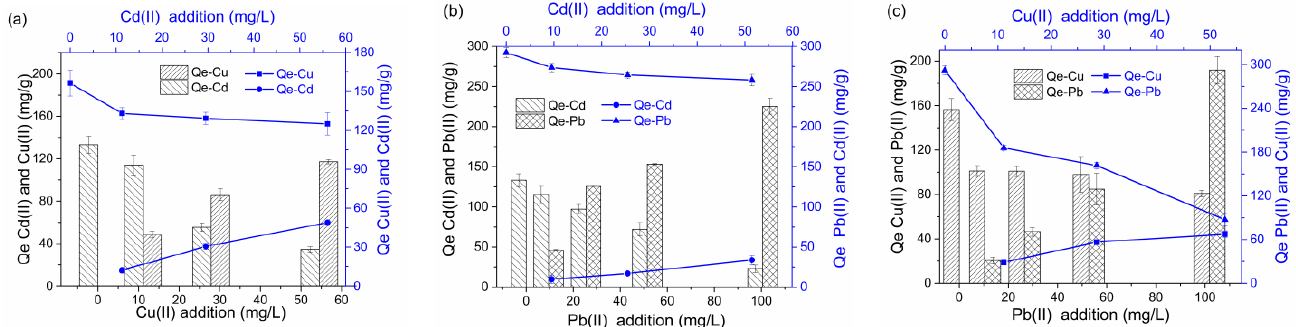
Figure 6. The effects of coexisting ions for Cd(II) and Cu(II) ( a ), Cd(II) and Pb(II) ( b ), and Pb(II)and Cu(II) ( c ) adsorption onto 15%Mg-BC.